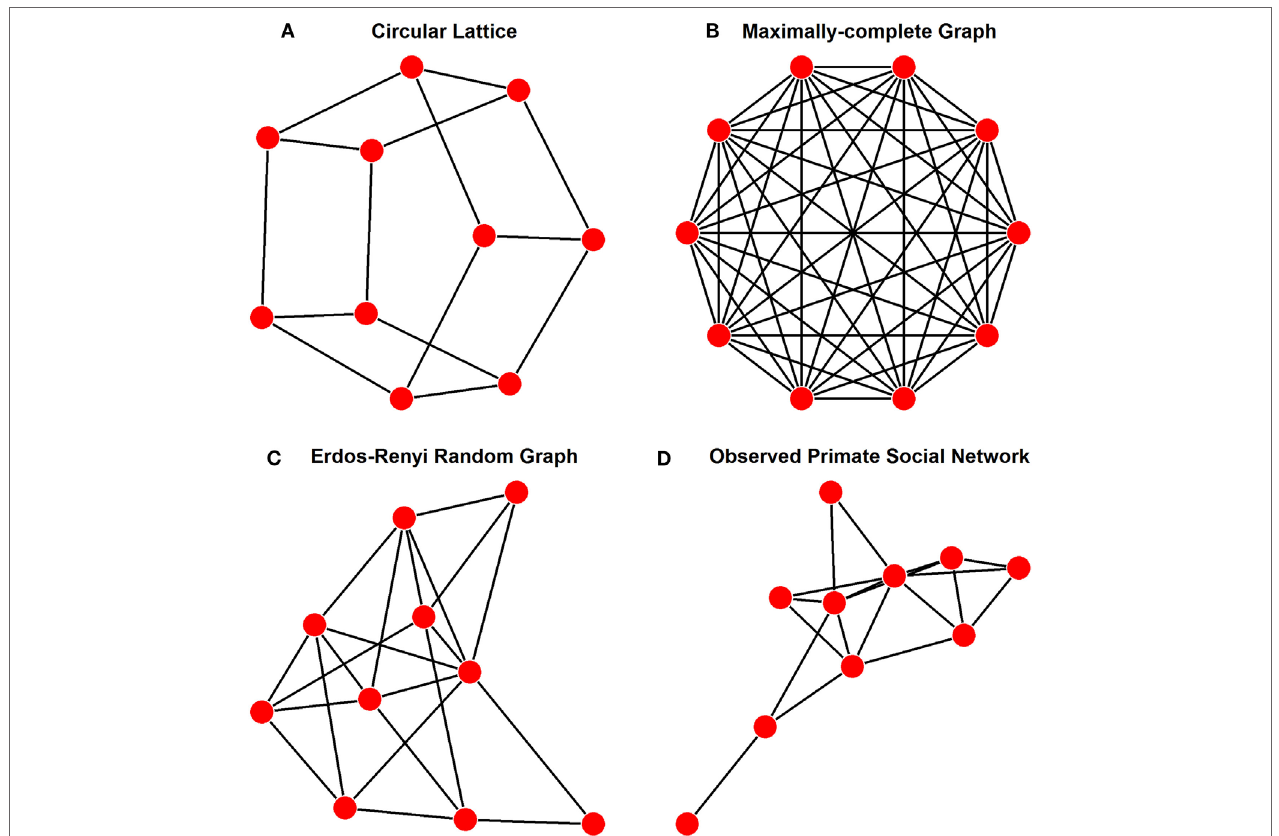
FIGURe 1 | Examples of a population of 10 individuals showing various representative network structures, as discussed in the text. These different structures and their applications are (A) lattice structure as has been used in other network models for disease transmission, where ties are regular, but not exhaustively complete; (B) maximally complete structure as was used for our idealized networks with free association, each individual is connect to all other individuals in the population; (C) Erdõs-Rényi generation structure with every possible tie existing with a probability of 0.25, thus the number of ties in this graph are a quarter of those present in panel (B) ; and (d) an example of an empirically observed network of social interactions among primates [ Pan troglodytes